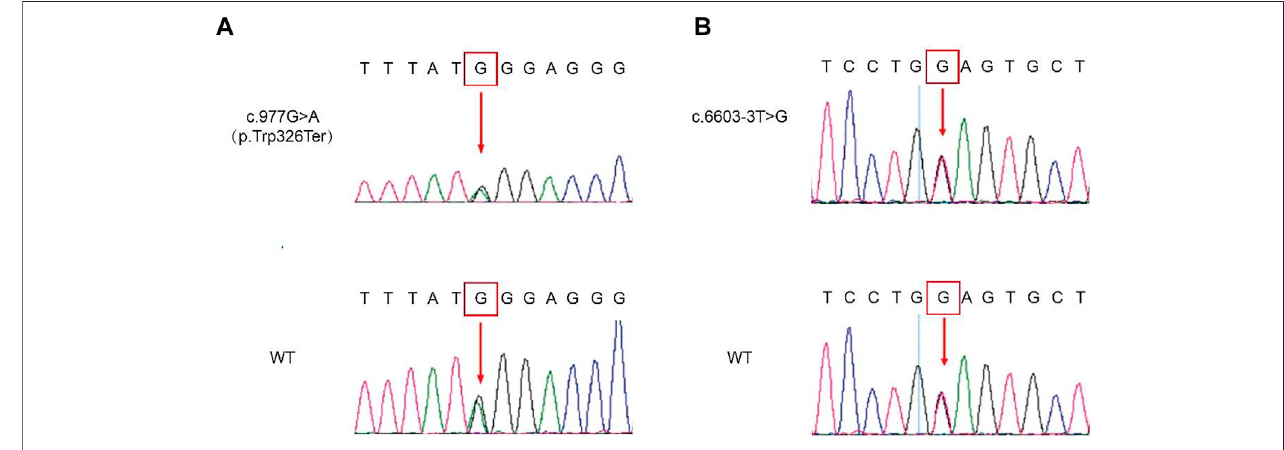
FIGURE3| Geneticsequencingresultsoftheprobandsandtheirparents.Mutatedsequencesoftheidenti fi edc.997G > A (A) andc.6603-3T > G (B) variant.The red arrow indicates the site of the base deletion or substitution.